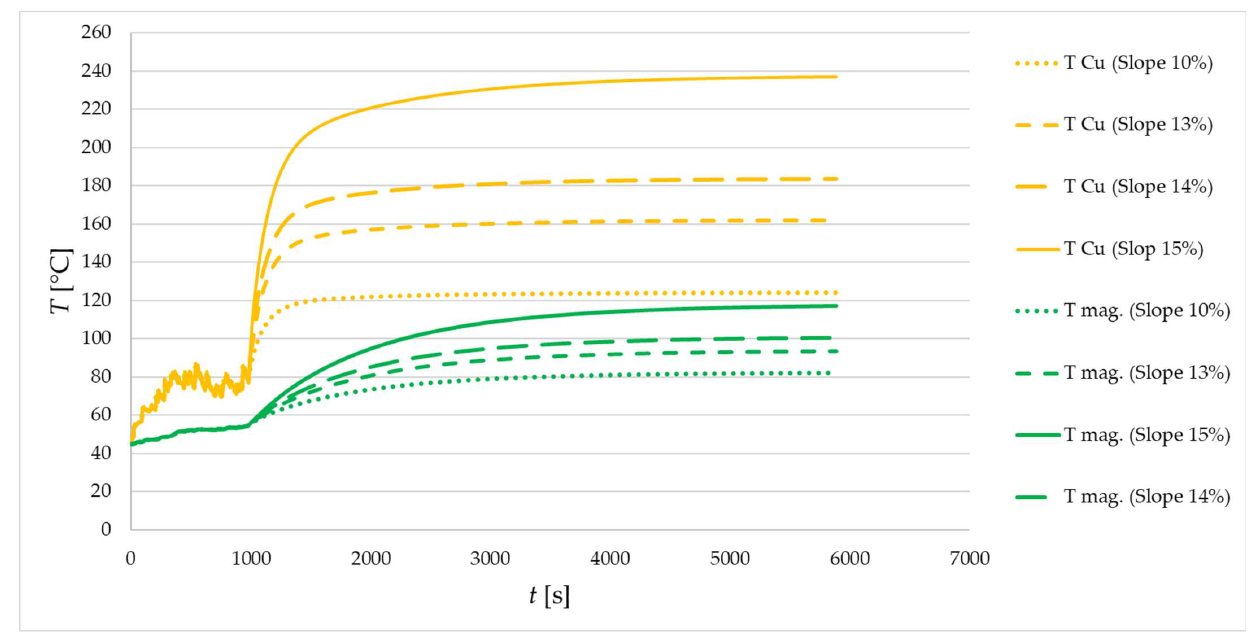
Figure 44. Calculated temperature waveforms of the winding and magnets while driving the car at a speed of v = 50 km/h, on the road with different slopes.